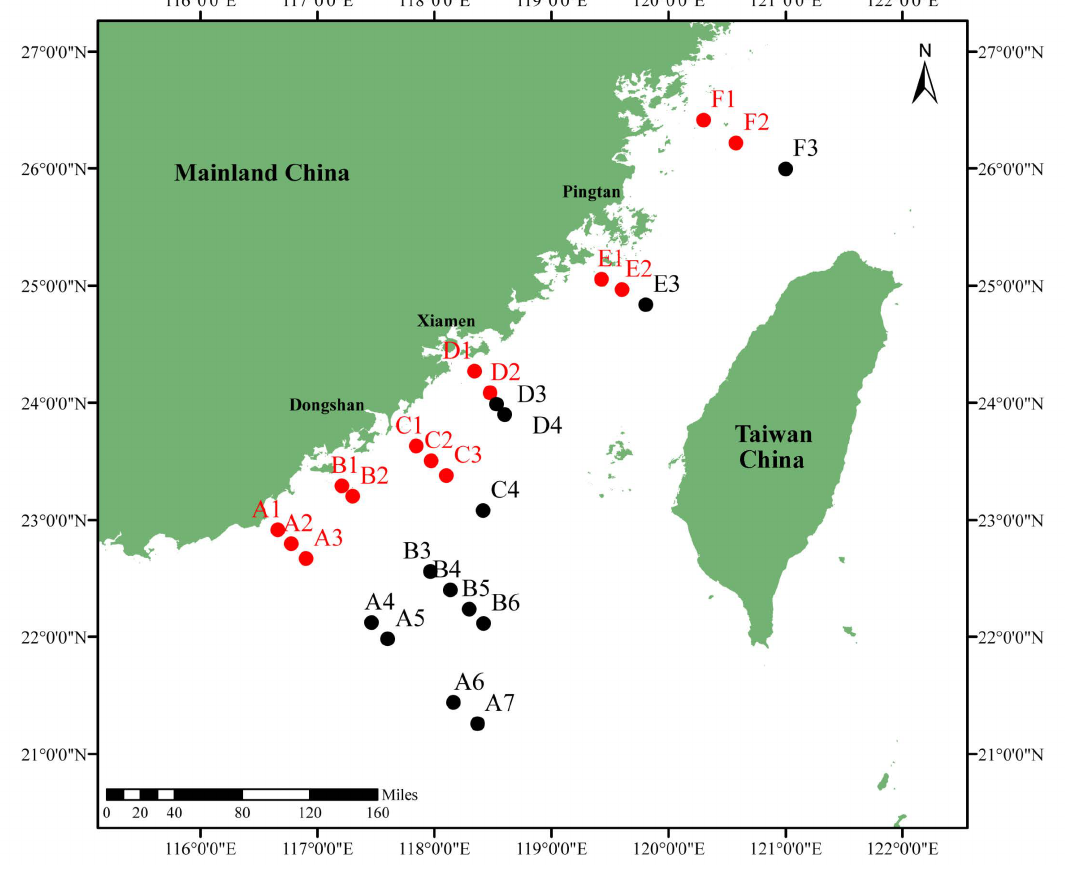
Figure 1. Map of the sampling stations in Taiwan Strait. The red dots indicate coastal stations while the black dots indicate the center in this study. Coastal and center regions were divided according to the distance of the transect from the beach, considering as a center region the one farther than 50